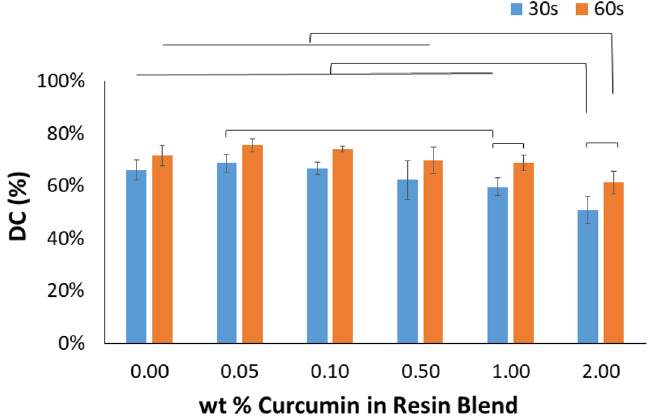
Figure 1. Degree of conversion of resin blends as a function of curcumin concentration and light curing time. Data is presented as average (%) ± one standard deviation (n = 6). Horizontal bars indicate a statistically detectable difference (p < 0.05).